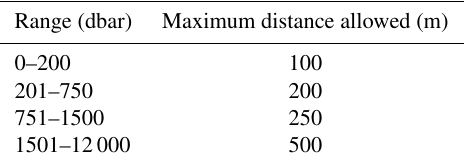
Table 1. Maximum distance criteria used when vertically interpo- lating the input